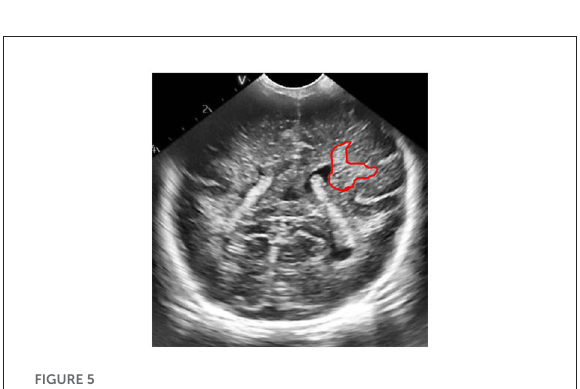
FIGURE5 ROI extraction result map.